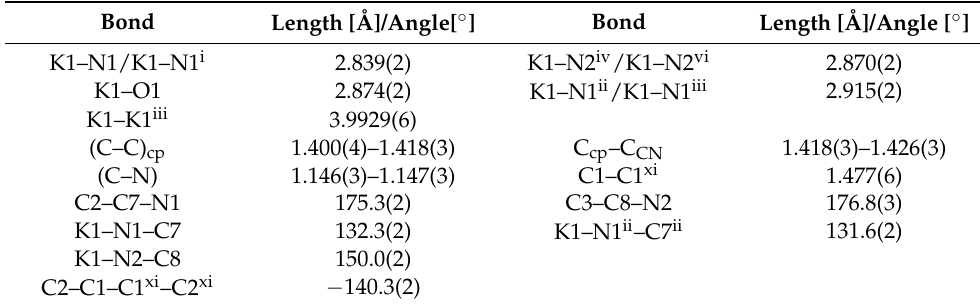
Table 4. Important bond parameters of compound 6a.